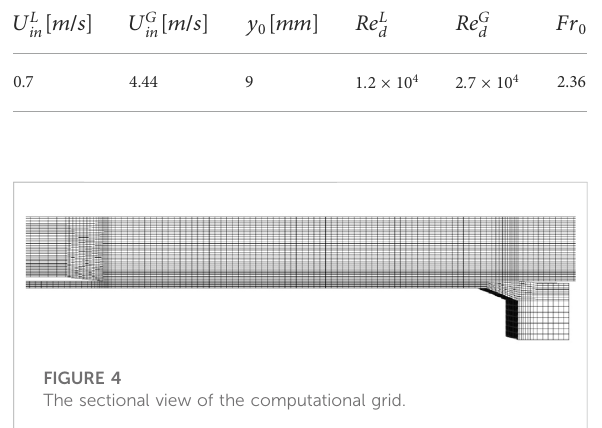
TABLE 1 Relevant parameters at the inlet and outlet.